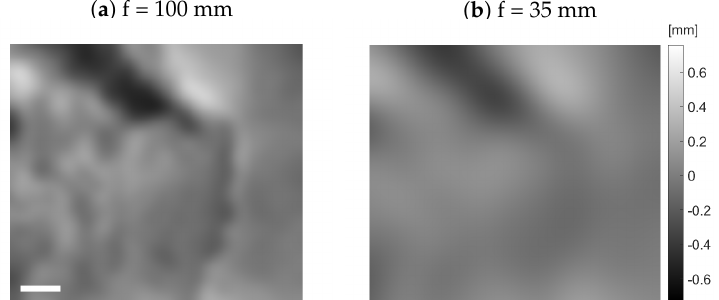
Figure 8. Model DEM of a SfM acquisition of area R1 with ( a ) 100 mm and ( b ) 35 mm focal length. The model DEMs were created by Gaussian low-pass filtering of the R1 reference DEM of Figure 5b with FWHM of 1.9 mm and 5.5 mm, respectively. The scalebar is 5